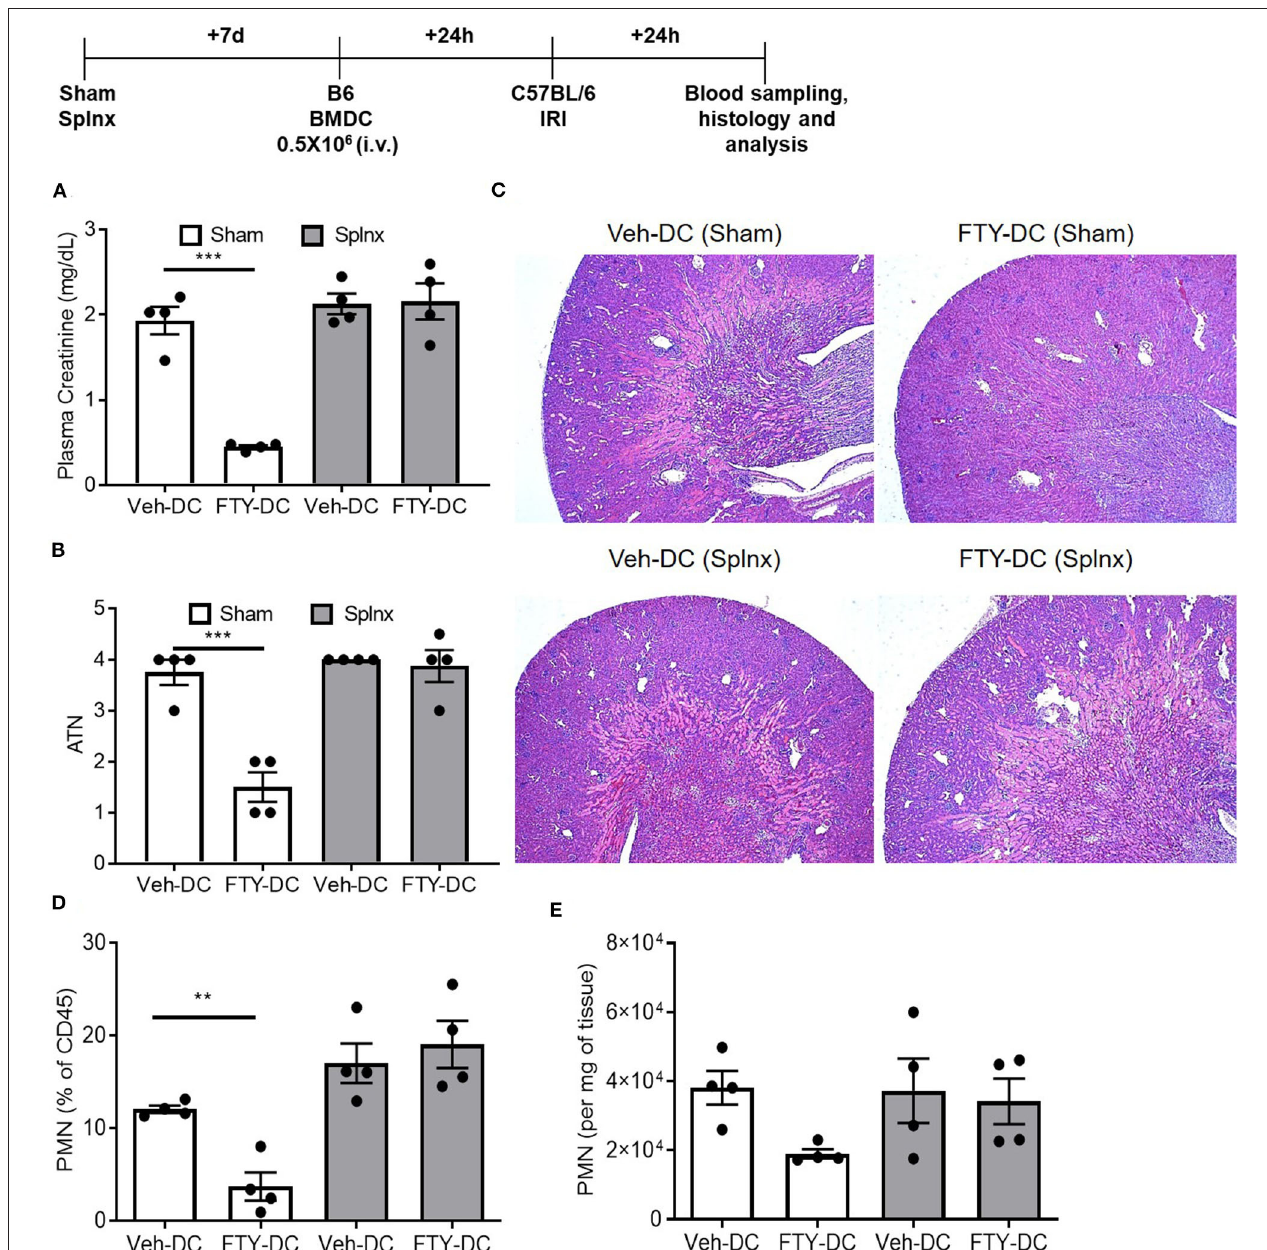
FIGURE 4 | FTY-DC require recipient spleen to protects kidneys from IRI. Protocol for experimental setup. (A) Plasma Creatinine (PCr). Mice were i.v. injected with 0.5 × 10 6 DCs (Veh-DC or FTY-DC) 7 days after splenectomy (Splnx) and 1 day before bilateral kidney IRI. (B,C) Quantification of tubular injury. Renal histology (H&E). (D,E) Flow cytometry of kidney tissue gated on neutrophils from Sham (no Splnx) mice either treated with Veh-DC or FTY-DC. Data represent means ± SEM, *** p ≤ 0.001, ** p ≤ 0.01; one-way ANOVA followed by Tukey’s post-test.